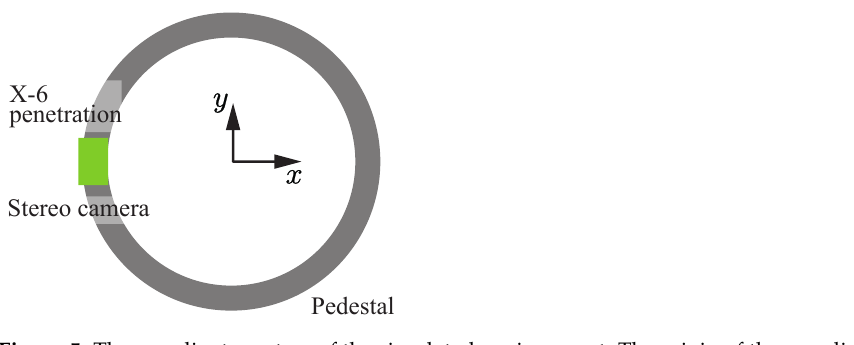
Figure 5. The coordinate system of the simulated environment. The origin of the coordinates is at the center of the pedestal where the z-axis is in the direction of